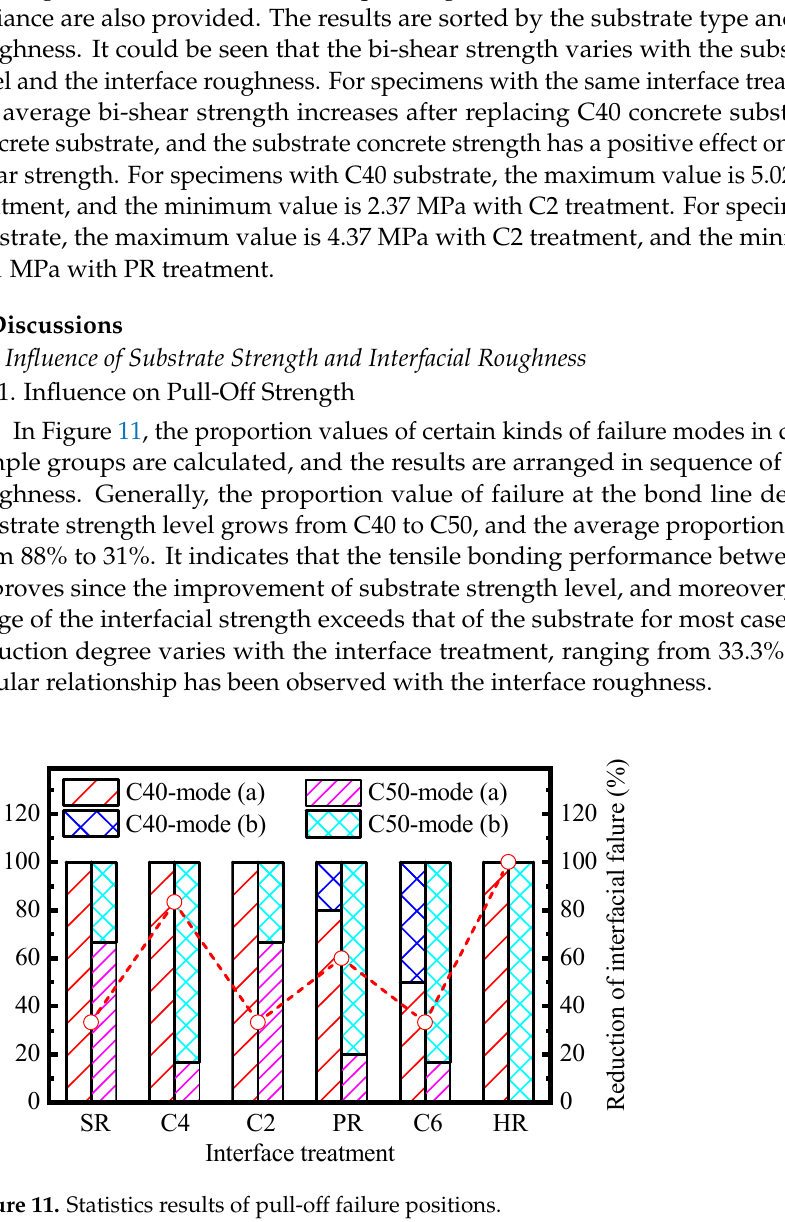
Figure 11. Statistics results of pull-o ff failure positions.